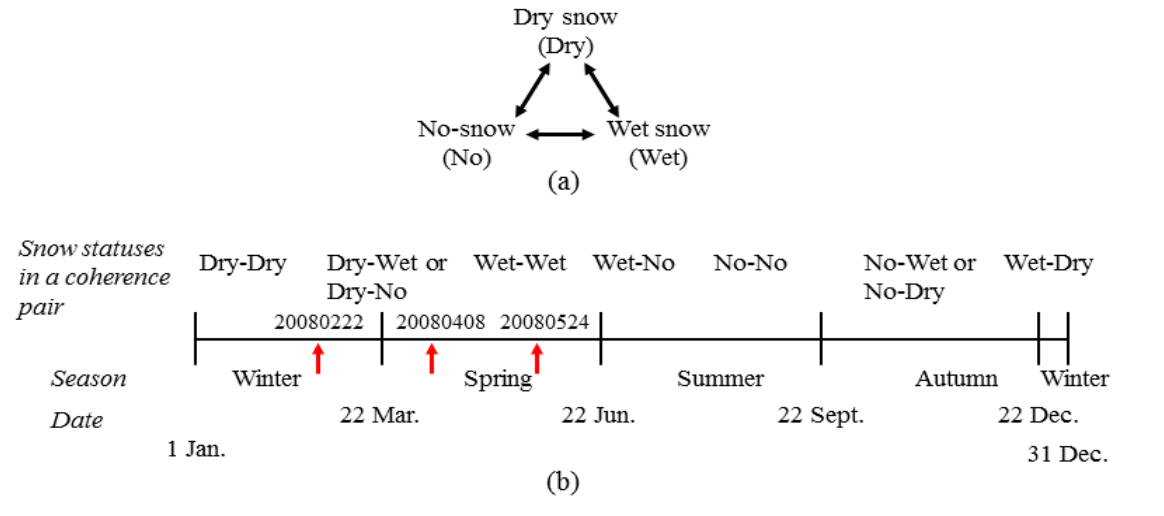
Figure 2. ( a ) Possible statuses and status changes of snow on the ground; ( b ) Nine statuses of snow within a pair of master and slave images from January to December. Red arrows showed acquisition dates of PALSAR data used in this